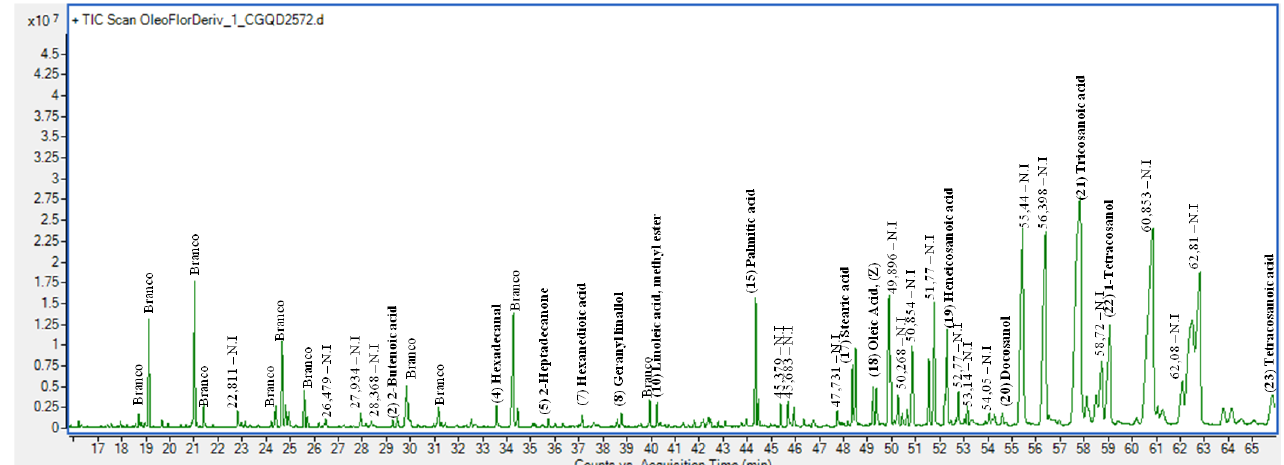
Fig 2 . Total ion chromatogram of the floral oil of nance ( Byrsonima sericea ) derivatised with TMS silylating agent. White = compound present in the white sample, N.I = unidentified